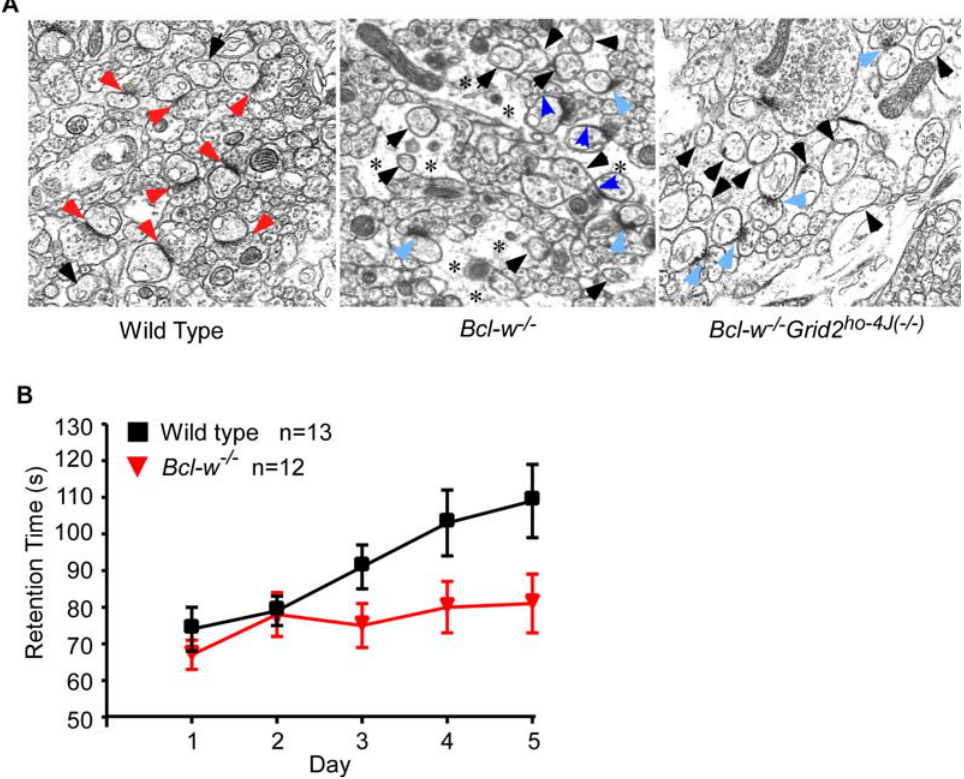
Figure 3. Abnormal Synapses and Rotarod Defect in Bcl-w 2 / 2 Mice. (A) Electromicrographs of synapses in wild type, Bcl-w 2 / 2 , and Bcl-w 2 / 2 Grid2 ho 2 4J( 2 / 2 ) mice. Red arrows indicate the normal synapses, light blue arrows the defective synapses with thick postsynaptic density, dark blue arrowheads the synapses with mismatched pre- and post- synaptic elements, black arrows the naked spines, asterisks the swelling Bergmann Glia encompassing Purkinje cells and synapses. (B) The learning profiles as represented by the average retention time for mice to stay on accelerating Rotarod bar during five consecutive testing days. The Bcl-w 2 / 2 mice had significant difference in retention time from that of wild type mice in day 2, 3, 4, and 5, P , 0.001.